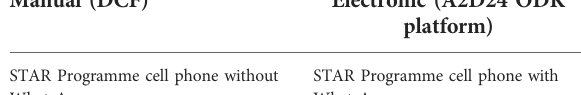
TABLE 1 Data collection summary.